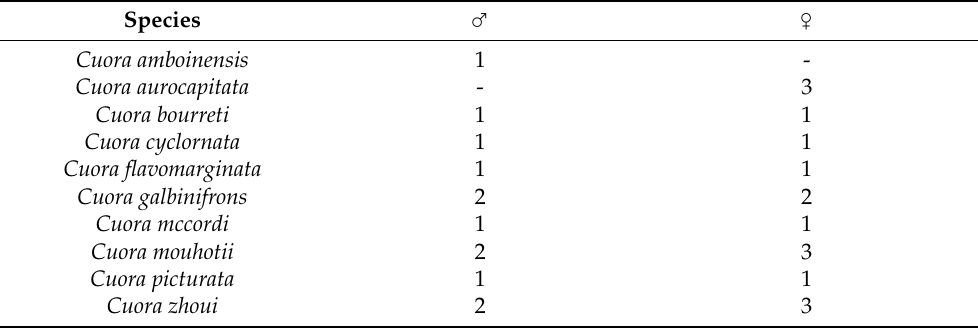
Table 1. Number of Asian box turtles per species and sex, analyzed in the current study. Species ♂ ♀ Cuora amboinensis 1 - Cuora aurocapitata - 3 Cuora bourreti 1 1 Cuora cyclornata 1 1 Cuora flavomarginata 1 1 Cuora galbinifrons 2 2 Cuora mccordi 1 1 Cuora mouhotii 2 3 Cuora picturata 1 1 Cuora zhoui 2